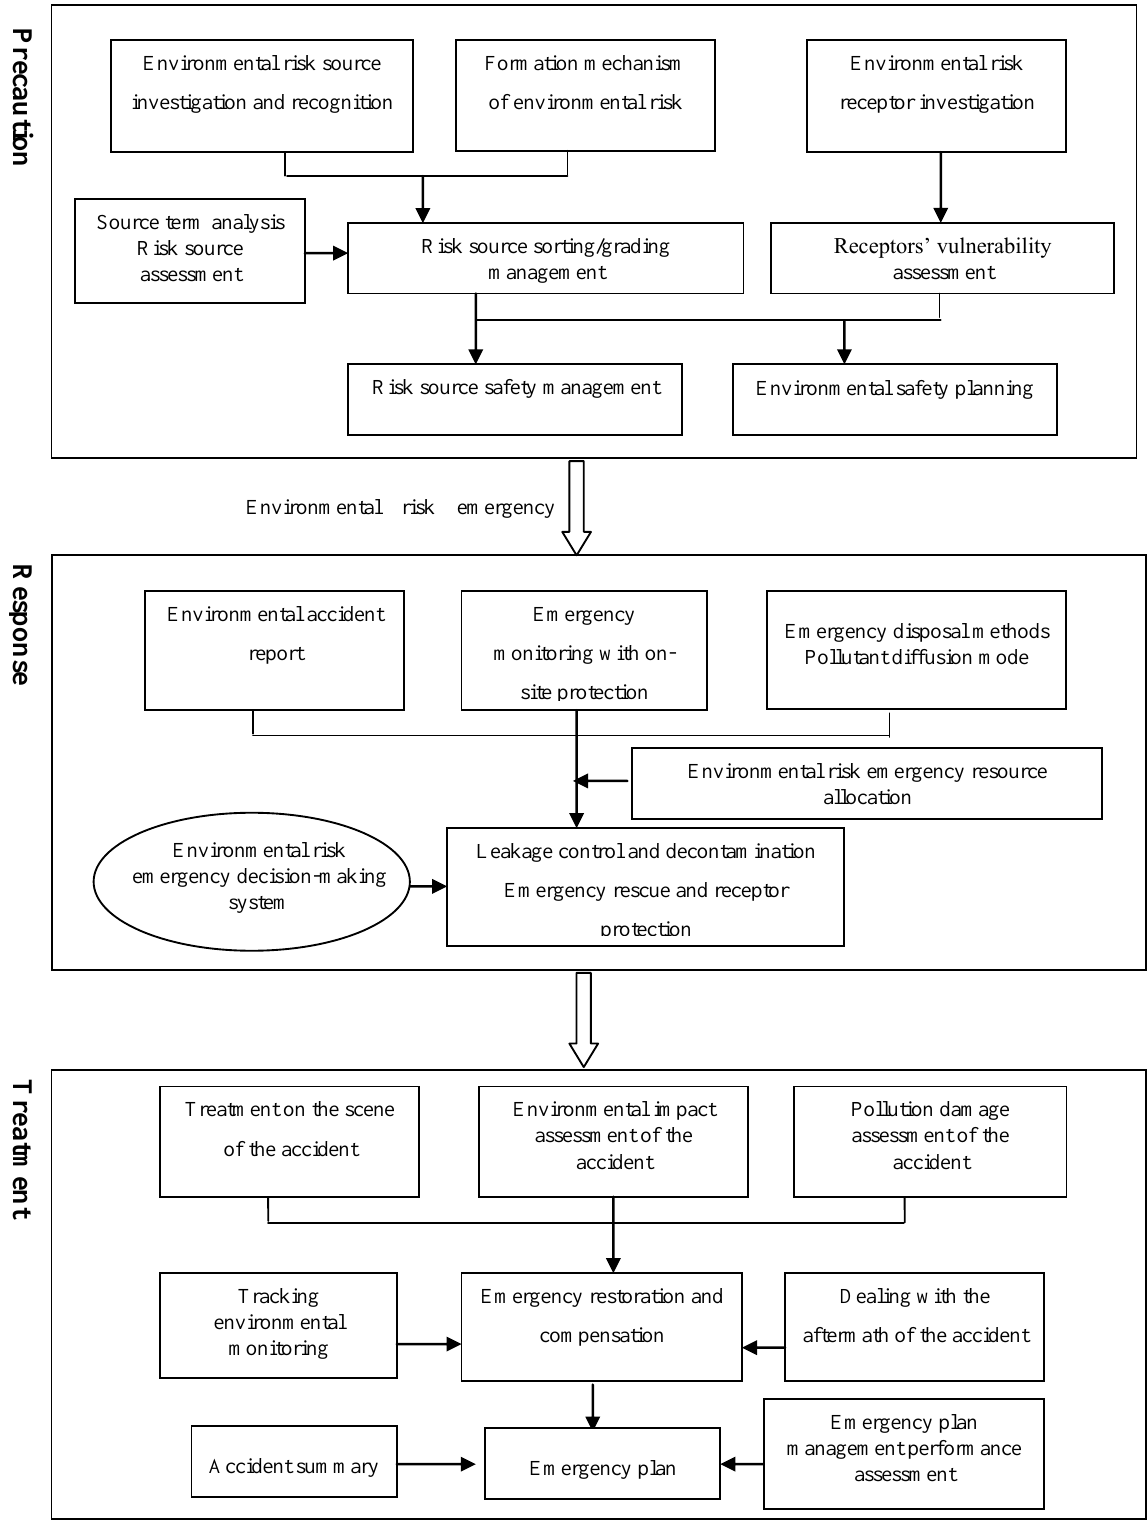
Figure 7. Framework of environmental risk whole-process management